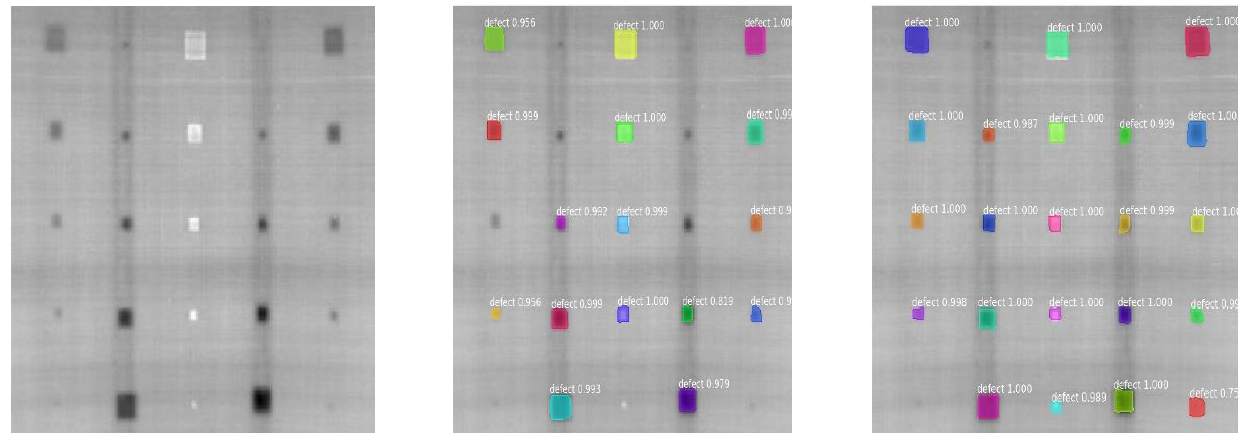
with synthetic data)